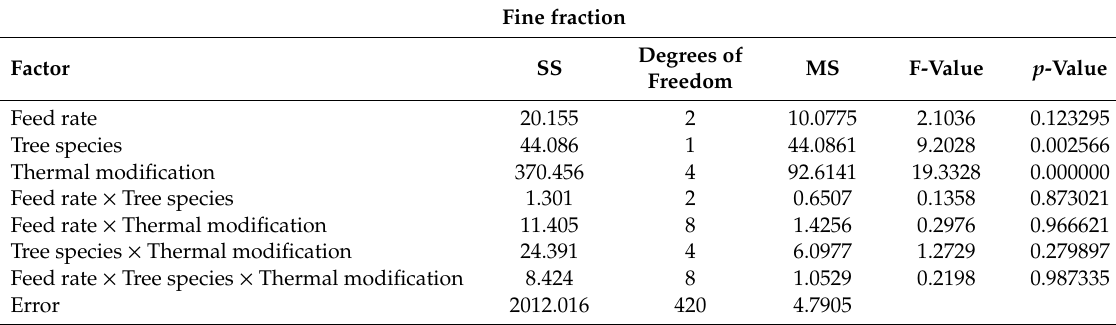
Table 6. Multiple factor analysis of variance in the case of fine